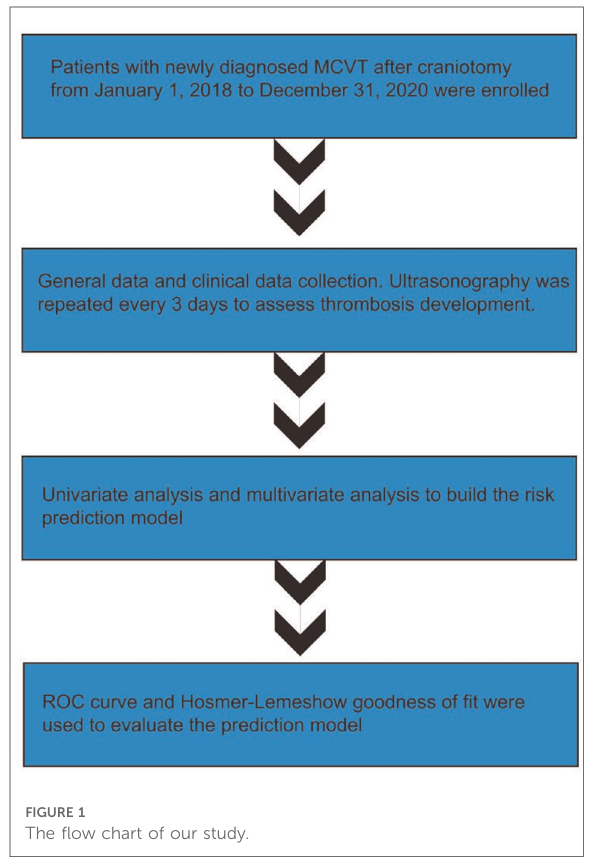
FIGURE 1 The fl ow chart of our